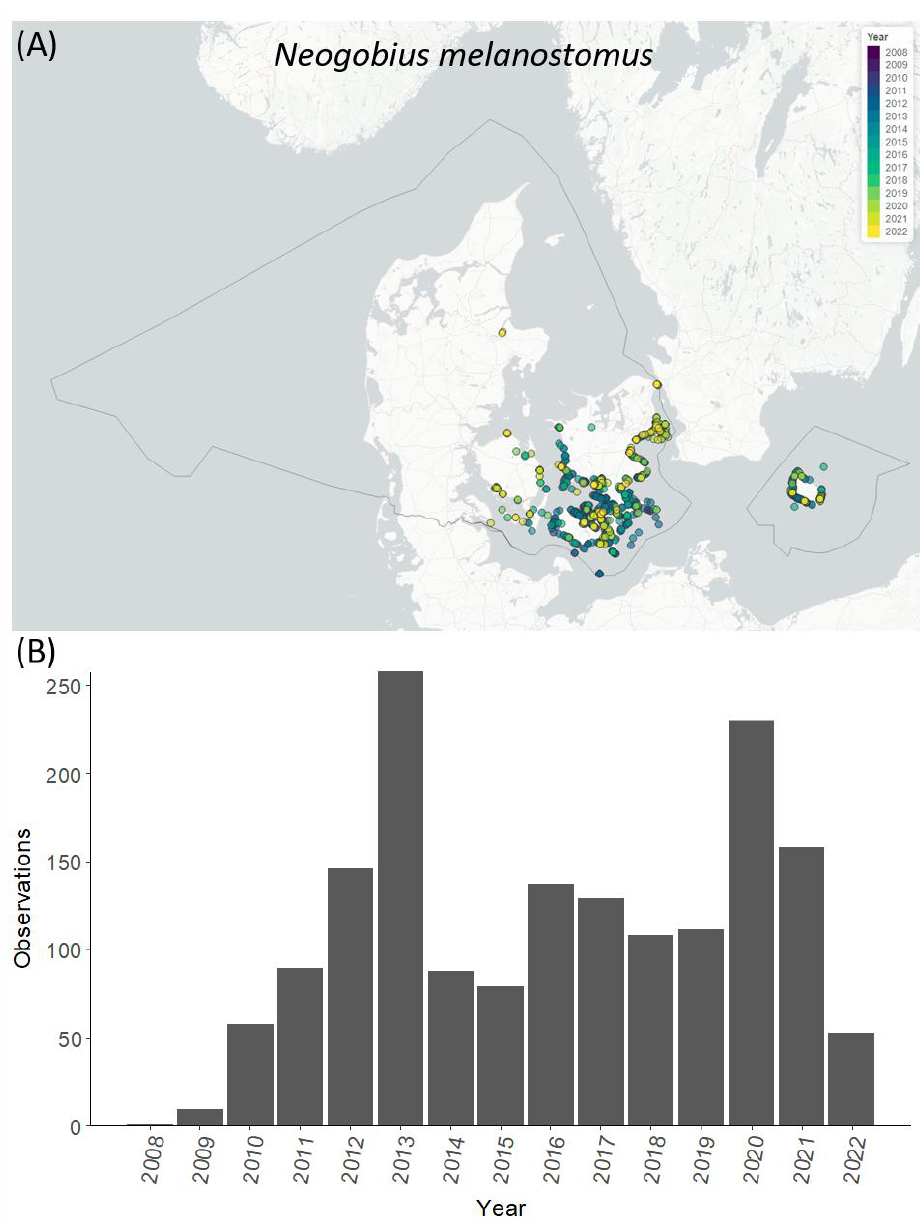
Figure 20. Distribution of Neogobius melanostomus from 2008 to 2022 ( A ); number of observations during the years 2008–2022 from the National Fish Atlas ( B ).